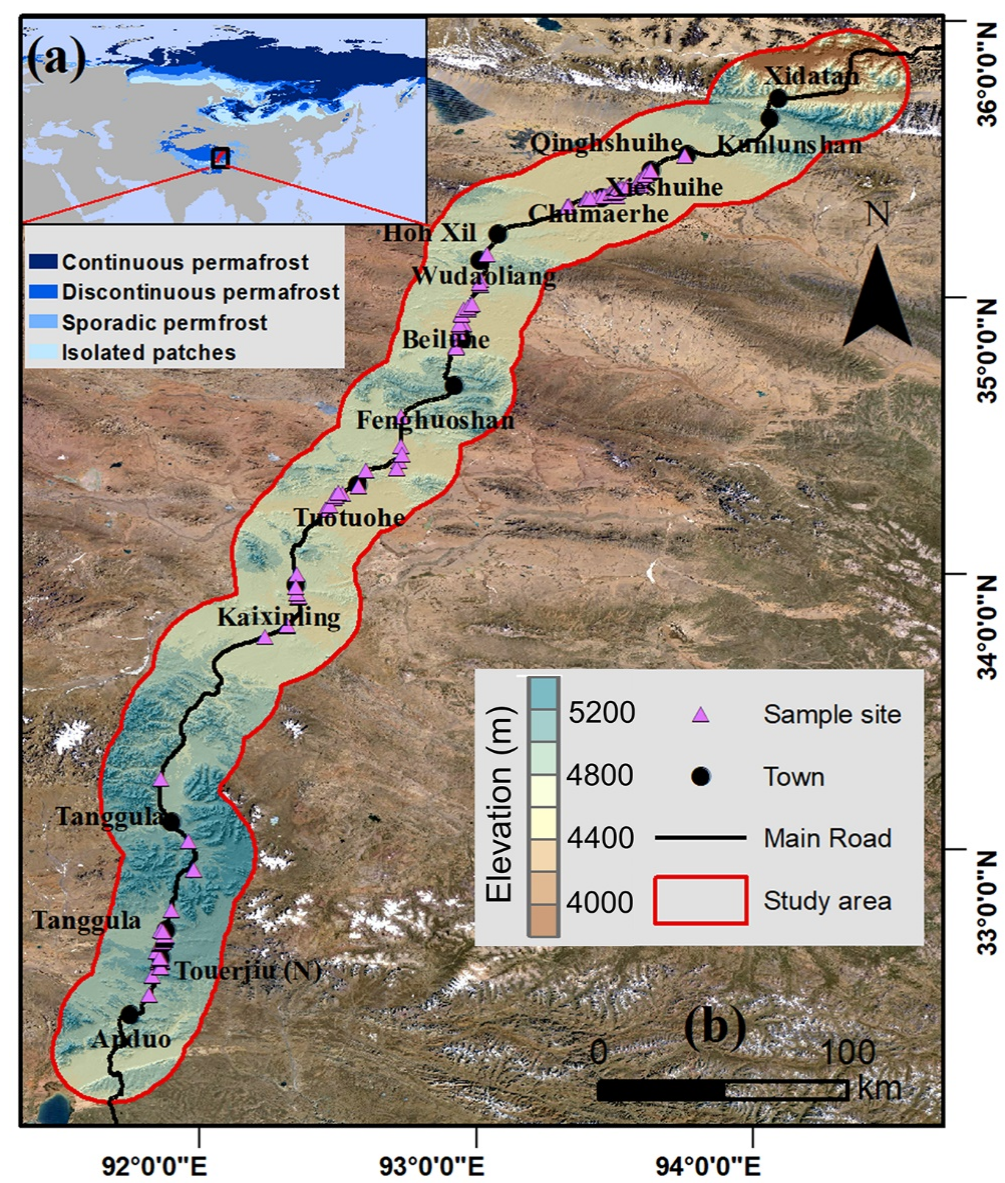
Figure 1. Map of the study area: ( a ) location of the study area across the permafrost region in the northern hemisphere. The permafrost extent data are from Obu et al. [1]; ( b ) topographic map of the whole study area based on a 90 m DEM data, including the locations of sample site in the subregions. The background is based on true color satellite imagery of the Landsat-8.